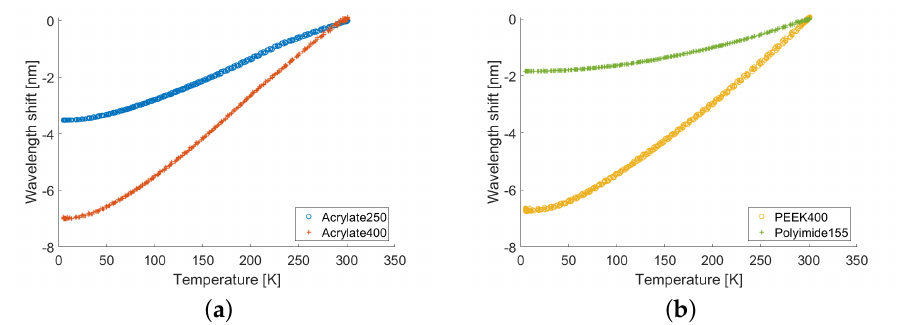
Figure 4. ( a ) Experimentally measured Λ ( T , T 0 = 300 K ) for the Acrylate250 and Acrylate400 samples over three thermal cycles. ( b ) Experimentally measured Λ ( T , T 0 = 300 K ) for the PEEK400 and Polyimide155 samples over three thermal cycles.